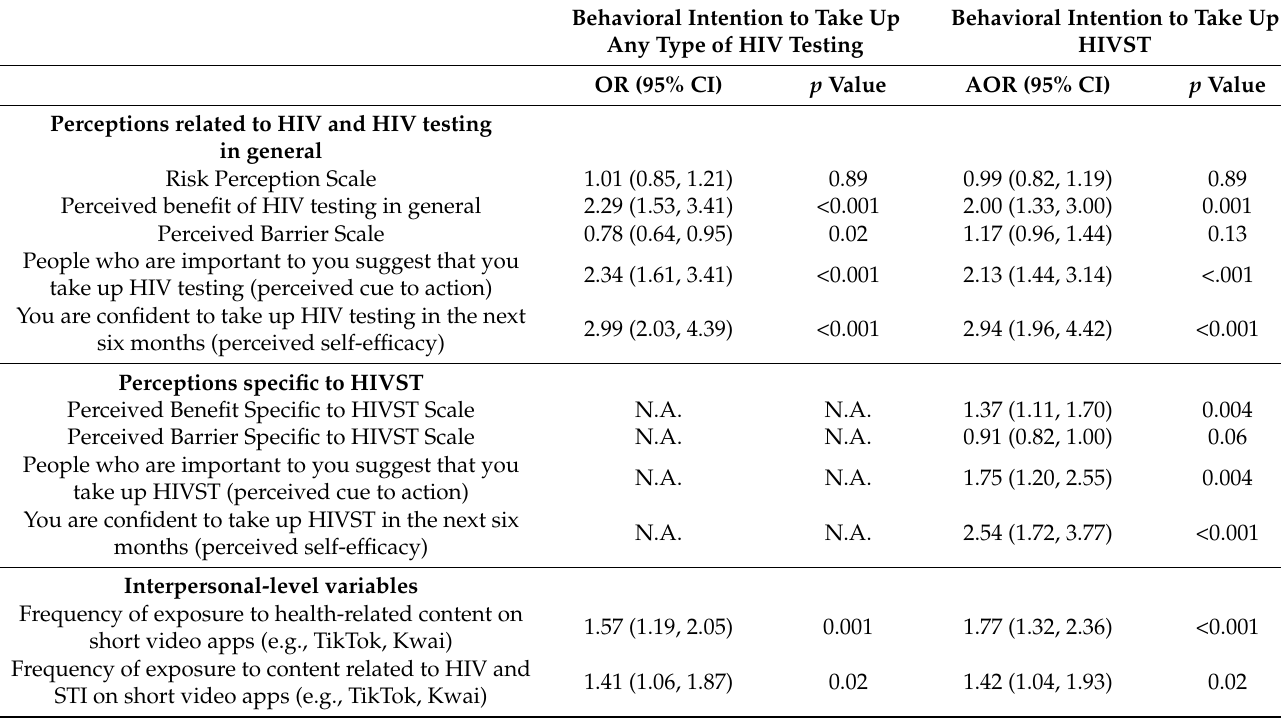
Table 4. Factors associated with behavioral intentions to take up any type of HIV testing and HIVST.